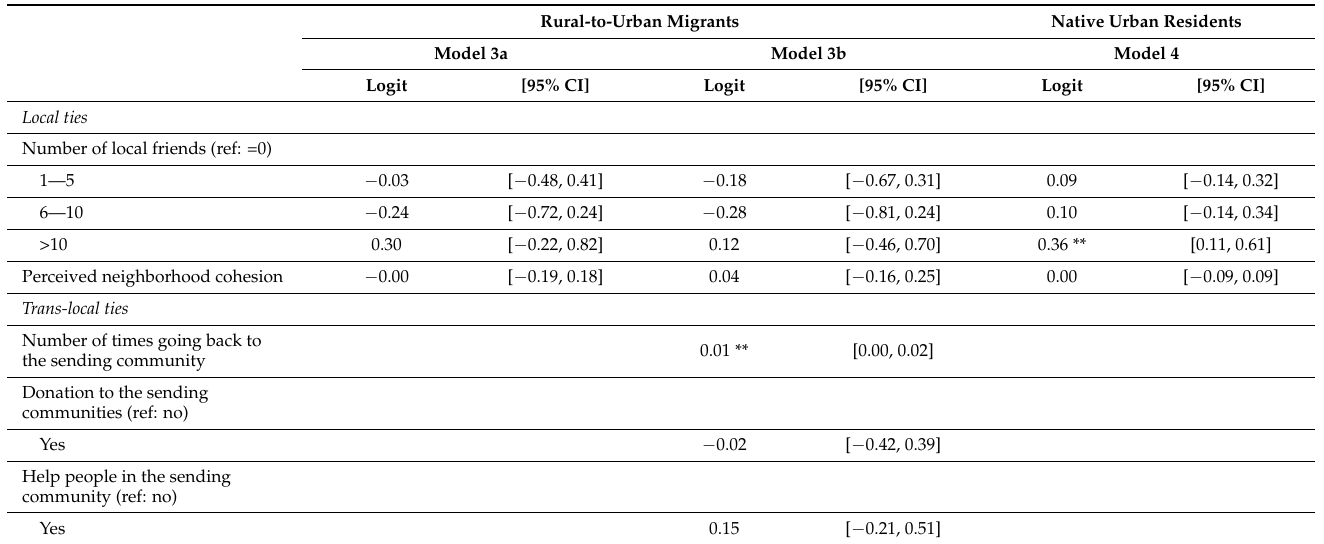
Table 4. The effect of local ties and trans-local ties on tobacco